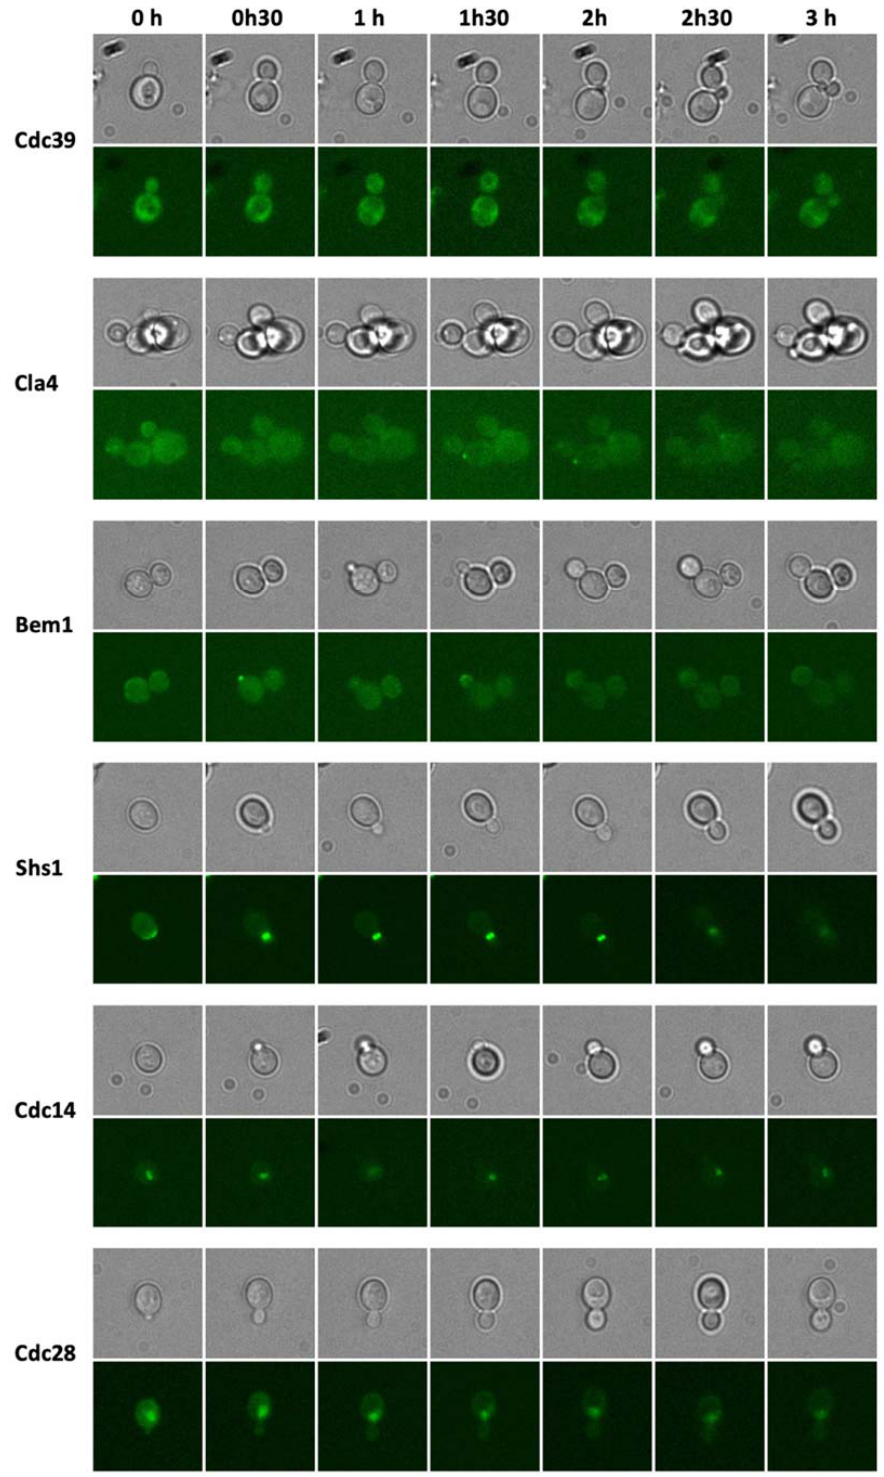
Figure 7. Time ‐ lapse fluorescence microscopy of selected GFP ‐ tagged clones related to the cell cycle. Figure 7. Time-lapse fluorescence microscopy of selected GFP-tagged clones related to the cell